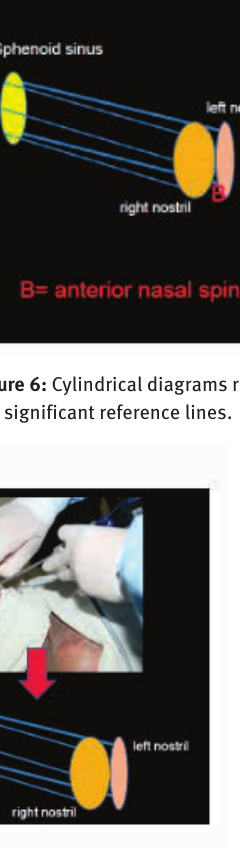
Figure 5: Images and a cylindrical diagram which are relevant to the EET approach.